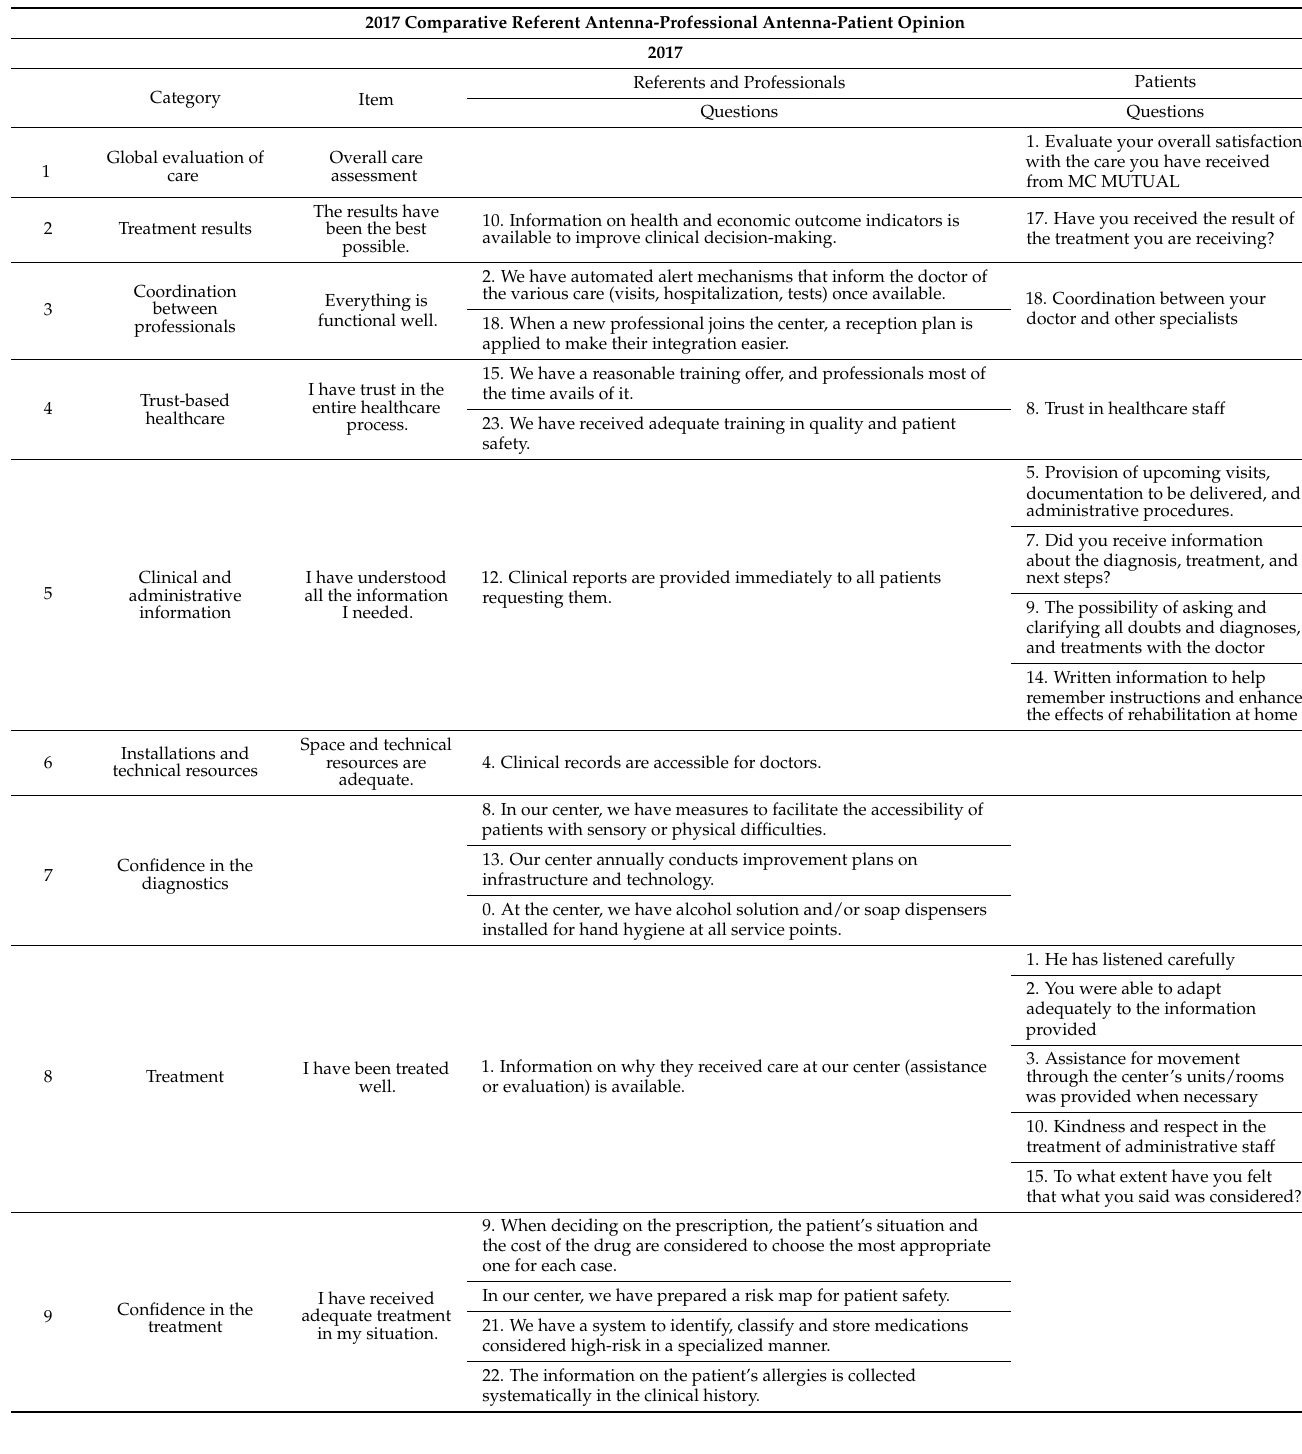
Table A2. Comparative Referent Antenna-Professional Antenna-Patient